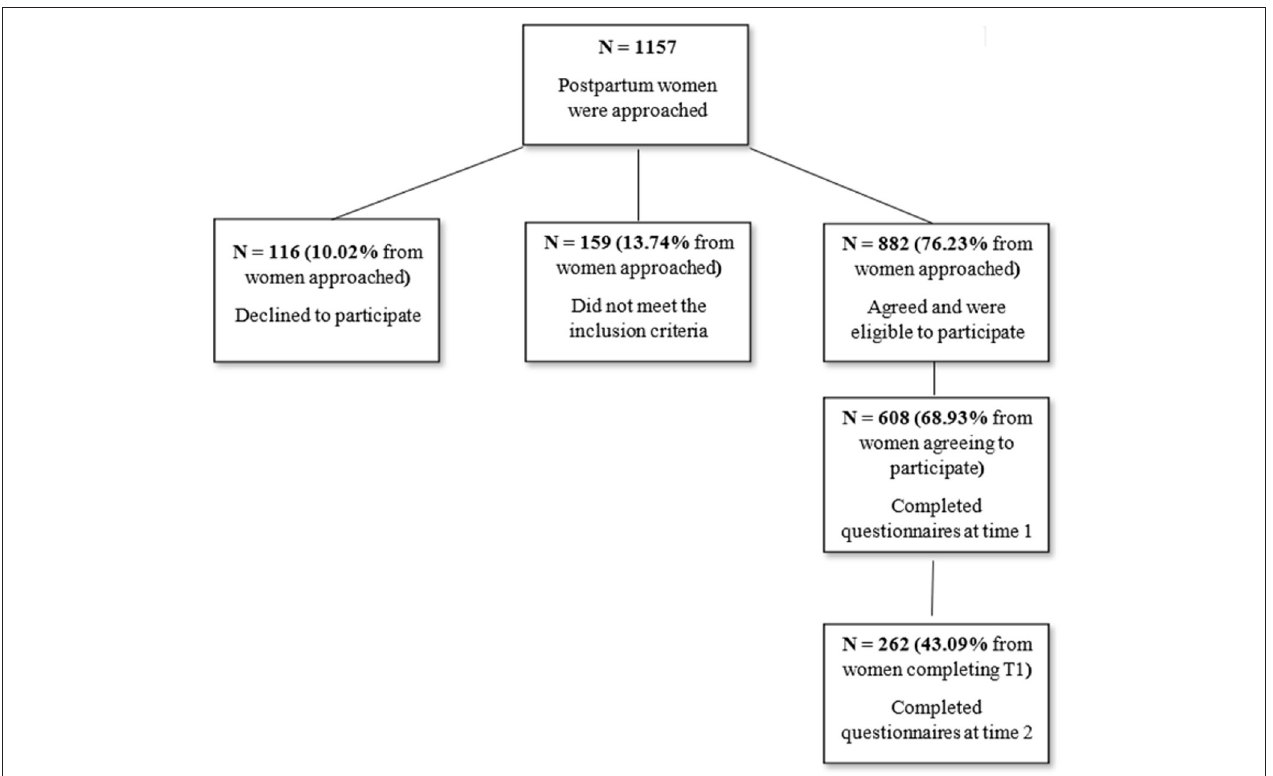
FIGURE 2 | Recruitment and data